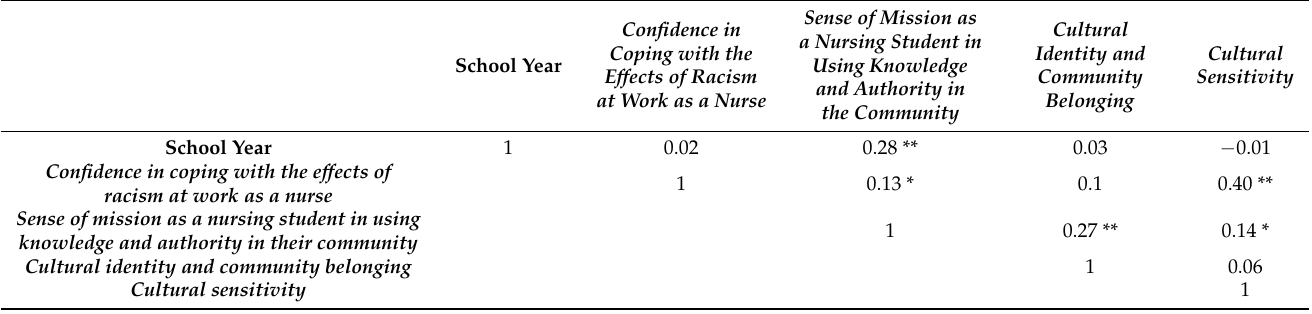
Table 3. Spearman’s correlation coefficient between factors according to the school year of the